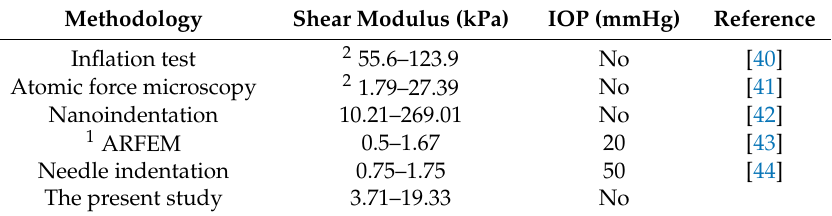
Table 1. Results of studies measuring the human corneal